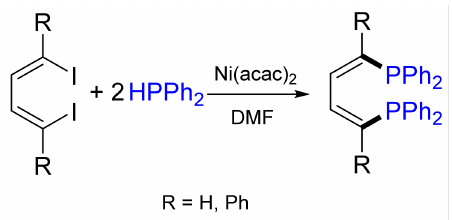
Figure 7. Nickel-catalyzed phosphination of vinyl iodides.